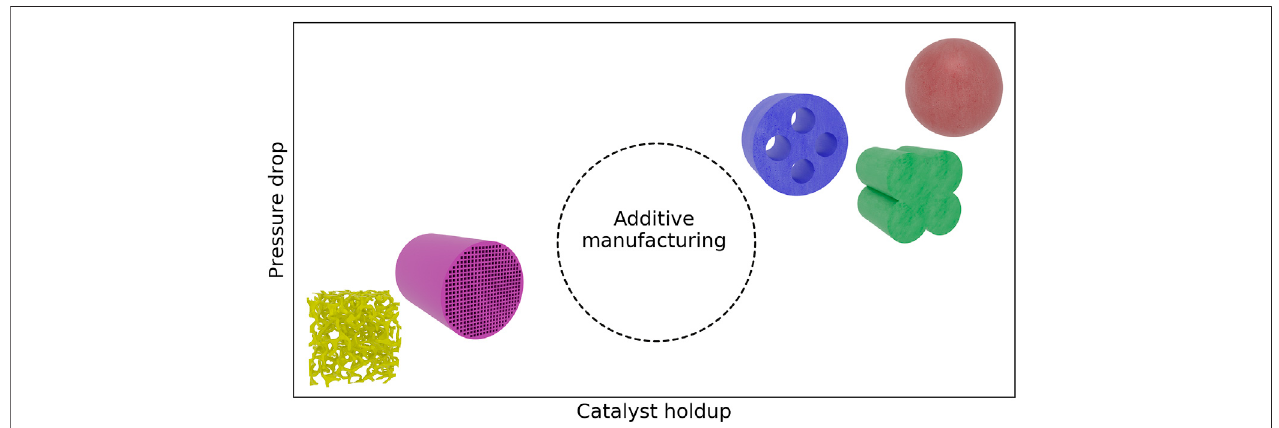
FIGURE4 | Qualitative comparison ofthe twoclasses ofconventional catalyst packings in terms ofpressure drop and catalyst holdup, alongside the potential3D- printing “ sweet spot ” . Structures are not shown to scale.